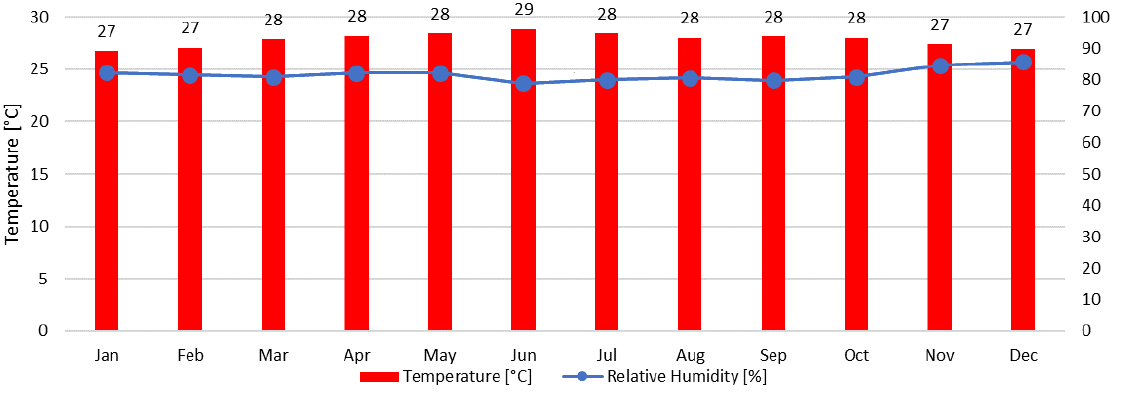
Figure 8. Singapore WET values ( A ) and percentage error ( B ). Analysing the error curve d-h, Figure 8B, it is possible to infer that in the Singapore climate for the WET calculation: The average month day data use (curve d-h) gives: •